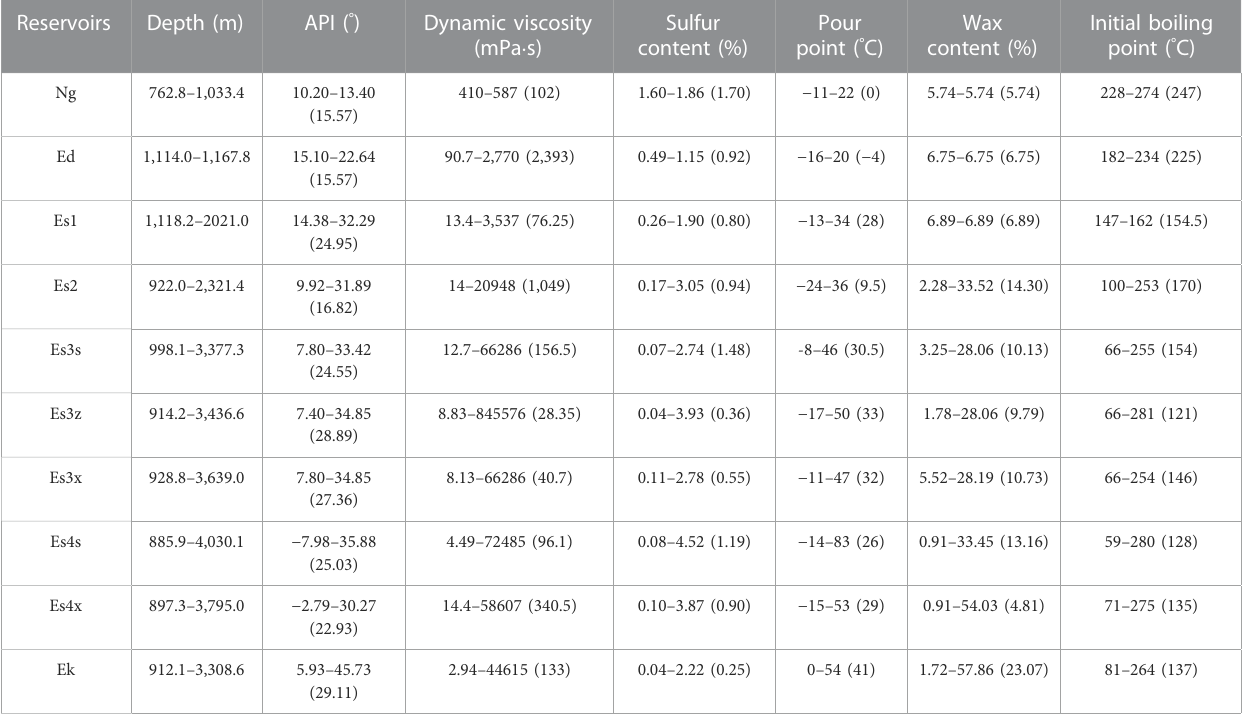
TABLE 1 Physical properties of crude oil from different formations in the study area.